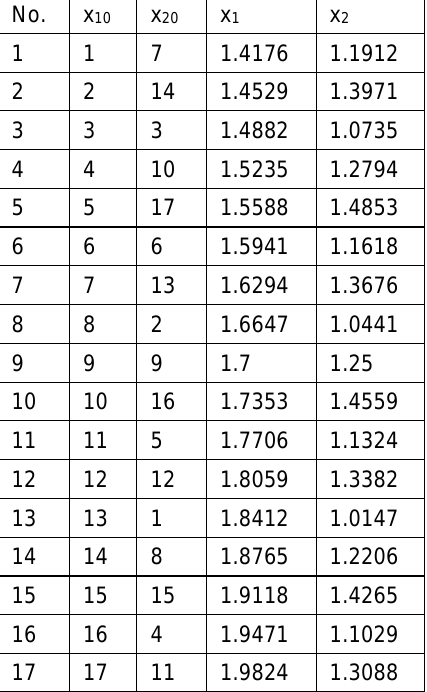
Table 3 – Distribution of the sampling points in the integral domain [1.4, 2.0] × [1.0, 1.5] Таблица 3 – Распределение точек выборки в интегральной области [1.4, 2.0] × Табела 3 – Расподела тачака узорковања у домену интеграције [1.4, 2.0] × [1.0,